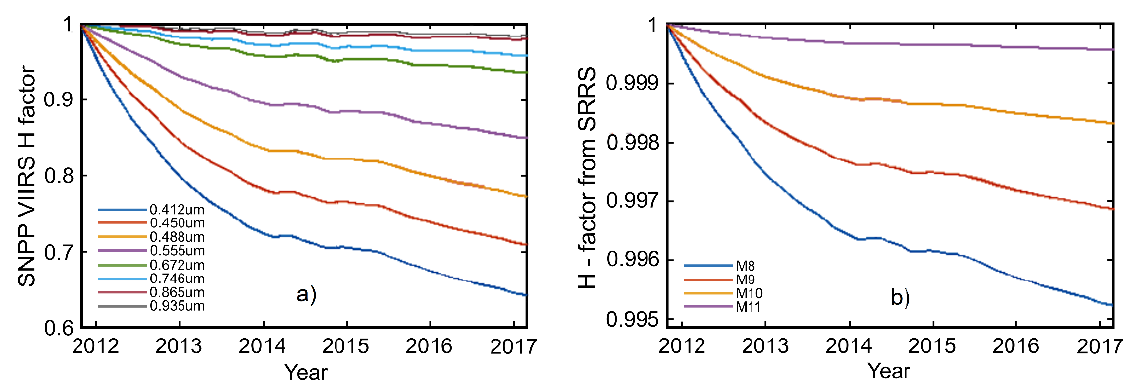
Figure 6. ( a ) Solar diffuser reflectance degradation over time, as monitored by eight detectors in solar diffuser stability monitor (SDSM) ( λ < 1 µ m) of SNPP VIIRS. ( b ) Modeled degradation of SD reflectance for SNPP VIIRS near infrared (NIR) bands (M8-M11, λ > 1 µ m) with Surface Roughness Raleigh Scattering (SRRS) model.